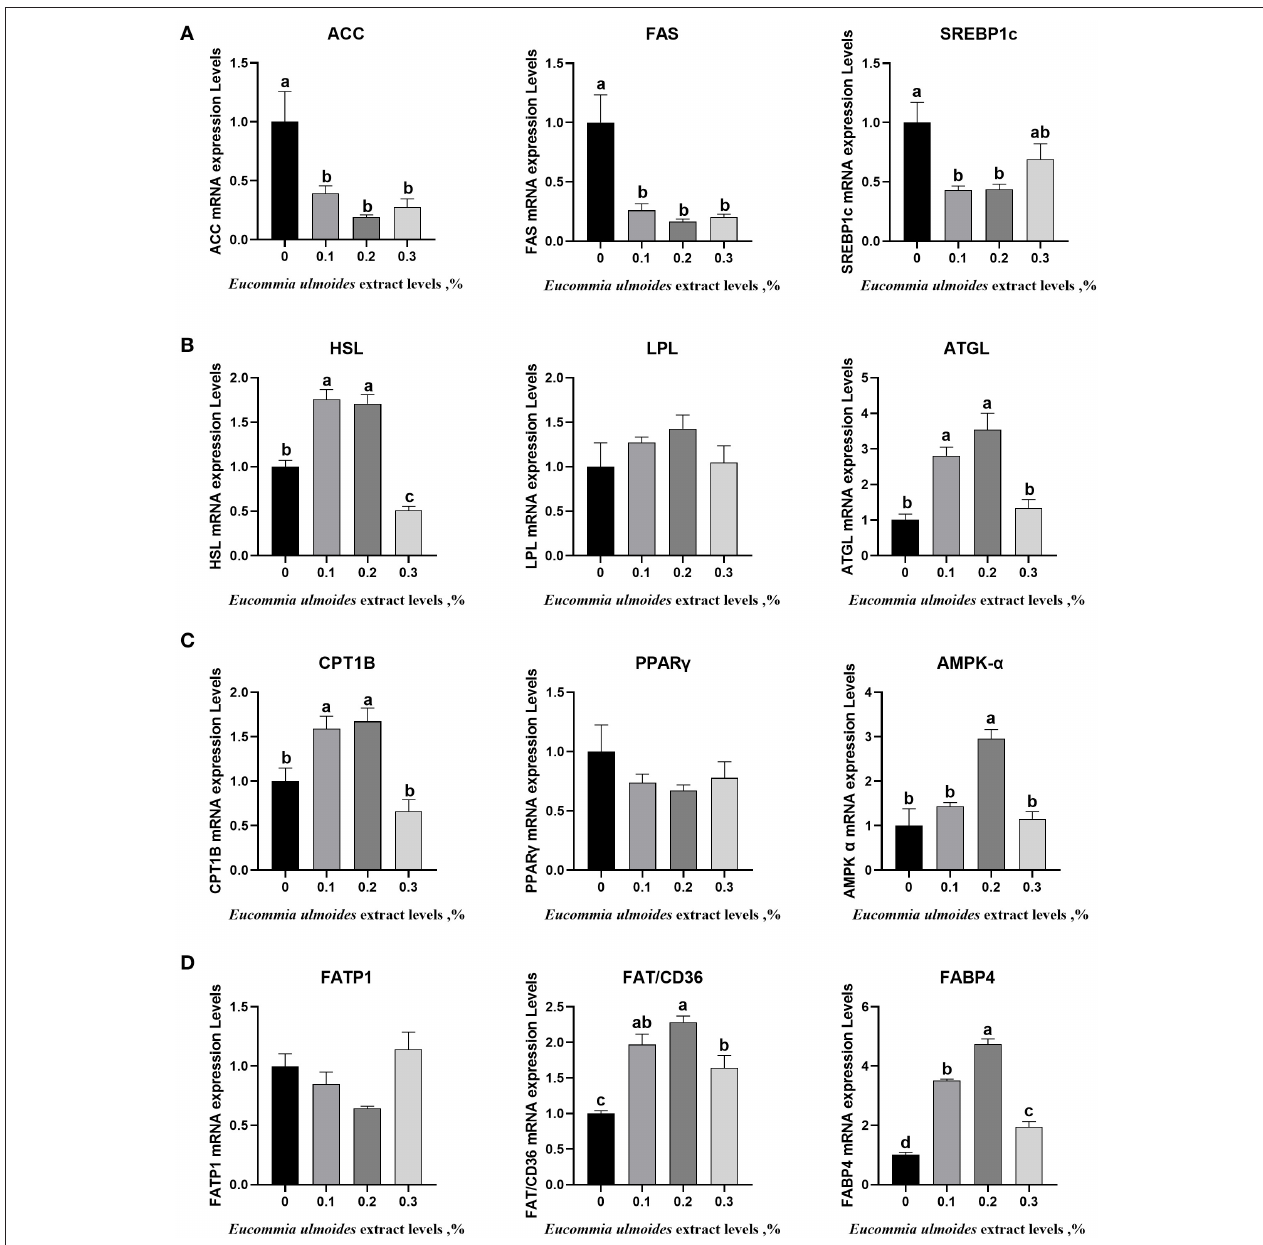
FIGURE 2 | (A) The relative mRNA expression levels of the key genes related to lipogenesis including acetyl-CoA carboxylase α (ACC), fatty acid synthase (FAS), and sterol regulatory element-binding protein-1c (SREBP1c), n = 8. (B) The relative mRNA expression levels of the key genes related to lipolysis including HSL, LPL, and ATGL, n = 8. (C) The relative mRNA expression levels of the key genes related to fatty acid oxidation including CPT1B, translocase peroxisome proliferator-activated receptor γ (PPAR γ ), and adenine monophosphate-activated protein kinase α (AMPK- α ), n = 8. (D) The relative mRNA expression levels of the key genes related to fatty acid transport including FATP1, FAT/CD36, and FABP4, n = 8. Data are expressed as means ± SEM ( n = 8). a − d Values with different letters are significantly different among dietary ELE treatments ( p <